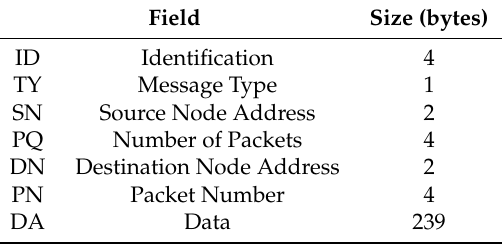
Table 3. Data message (DM) format.